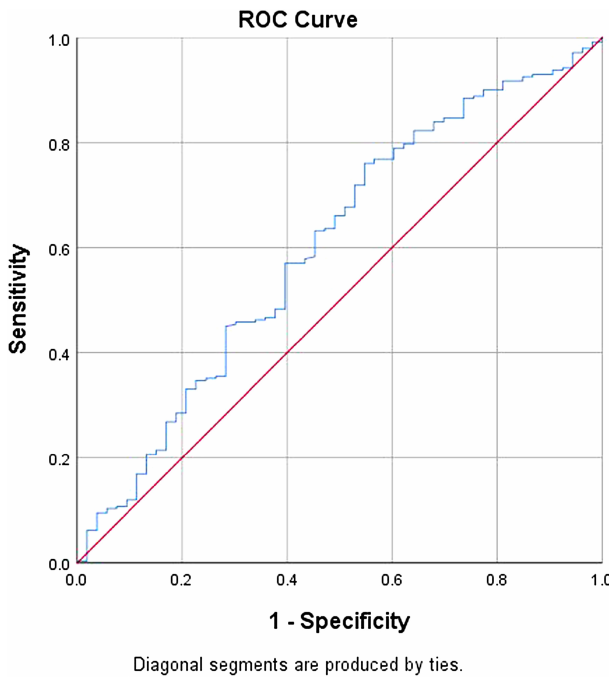
Figure 1. Receiver operating characteristic curves to assess the best cutoff value of systemic immune-inflammation index. AUROC: 0.602; 95% CI: 0.515-0.689; P = . 019, with a sensitivity of 0.756 and specificity of